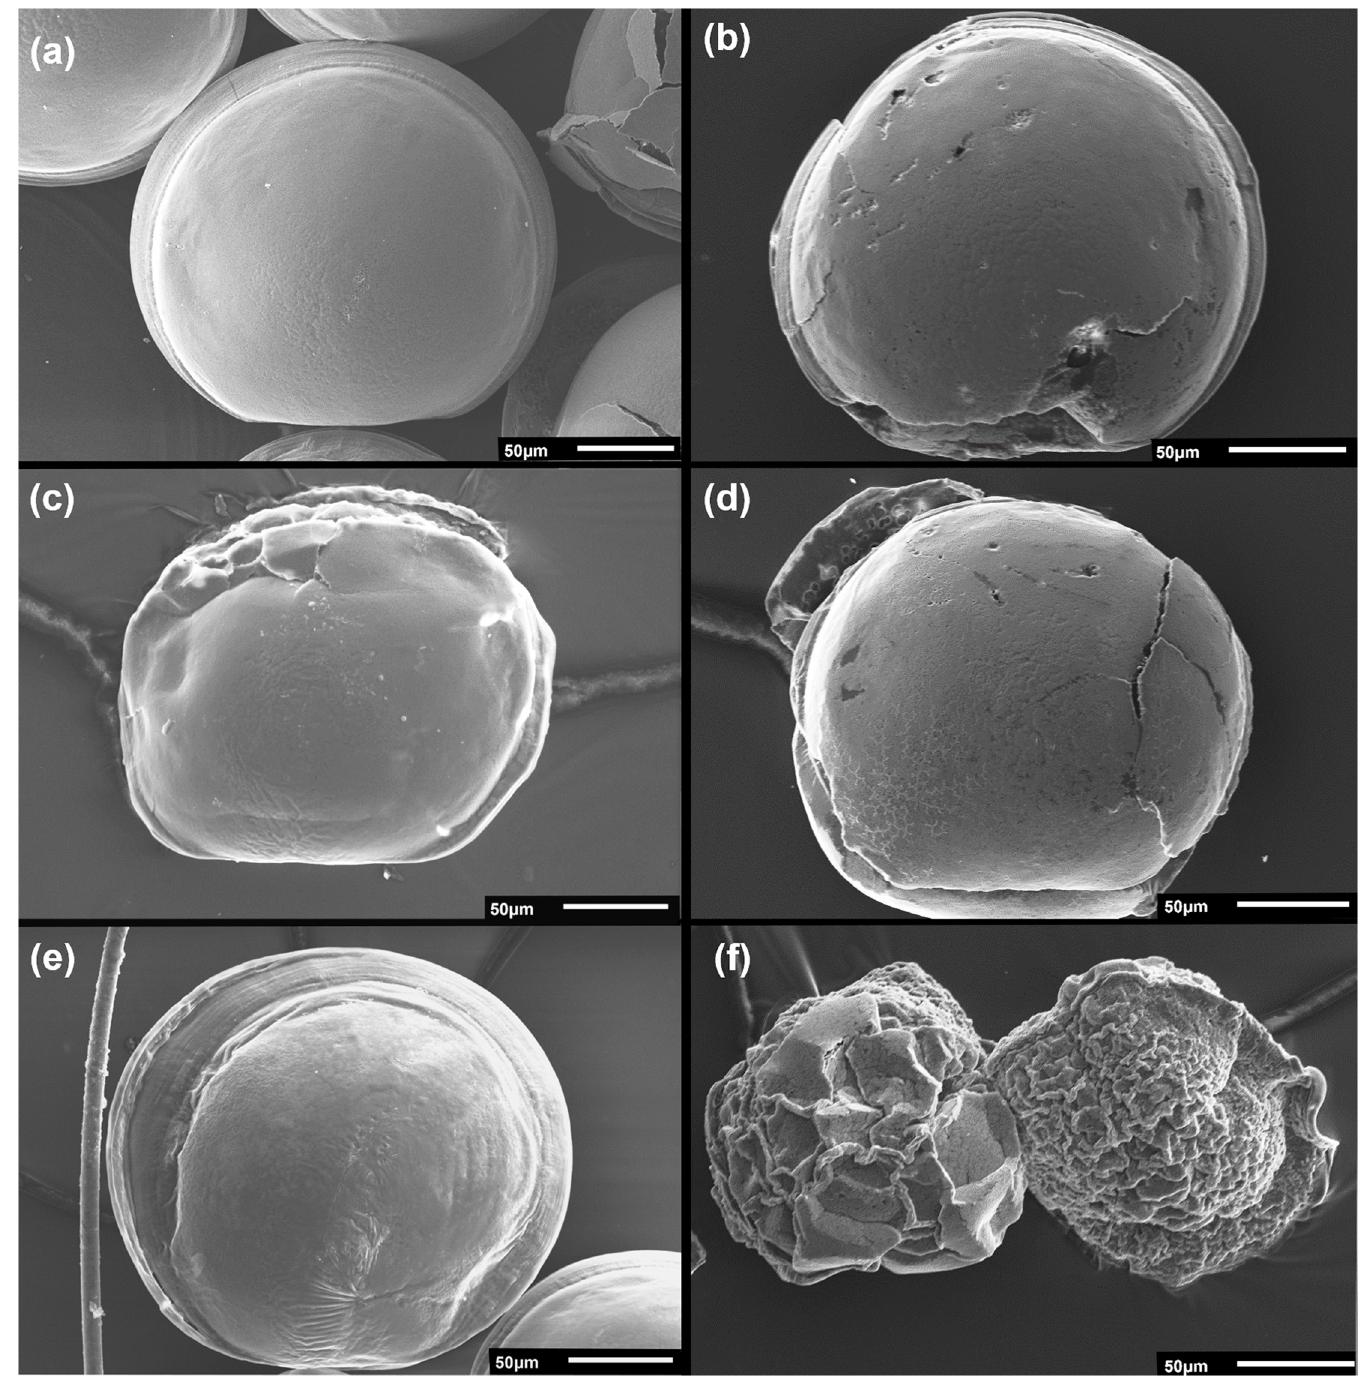
Fig 3. SEM images of D-larvae from various experimental treatments. (a) normally developedD-larva from the control treatment (pH 7.98 and -1.6˚C, x370), and (b-e) damagedand/or malformedlarvaefrom reducedpH (7.65) treatments at varioustemperatures (d: -1.6˚C, x430, b: -0.5˚C, x450, c and e: 0.4˚C, x400), (f) extremelymalformed(left) and uncalcified(right) larvae from pH 7.65, -1.6˚C (x450). PI: prodissoconch I; PII: prodissoconch II. All scale bars are 50 μ m.